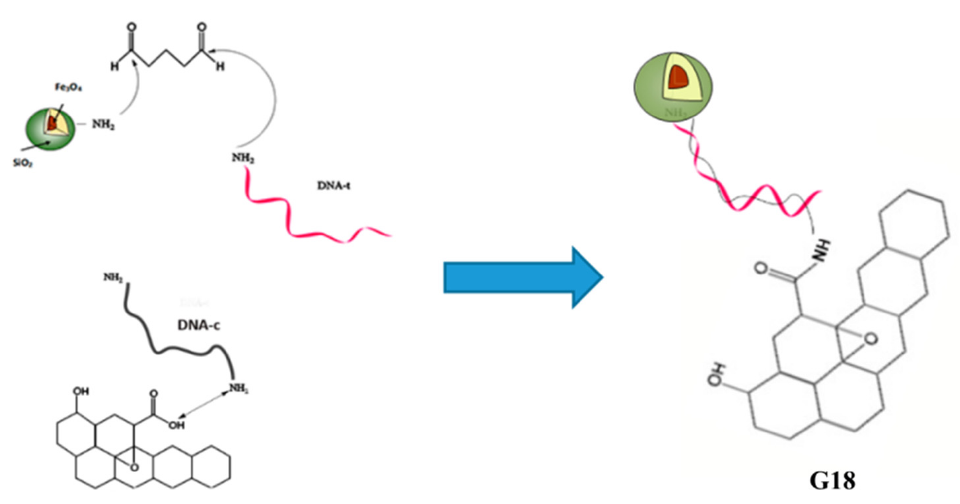
Figure 20. A plausible mechanism for the detection of DNA ( G18 ) using the FRET quenching process. Reprinted from [75] with permission from MDPI.